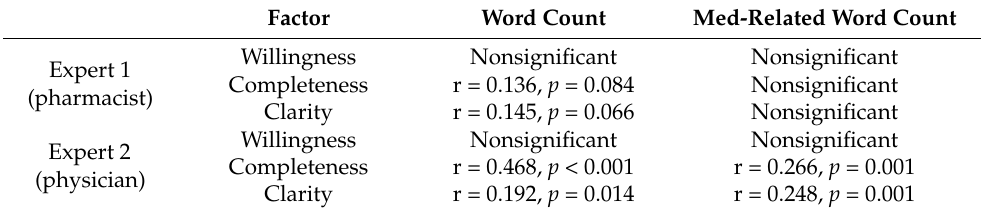
Table 3. Correlation results between word counts and expert